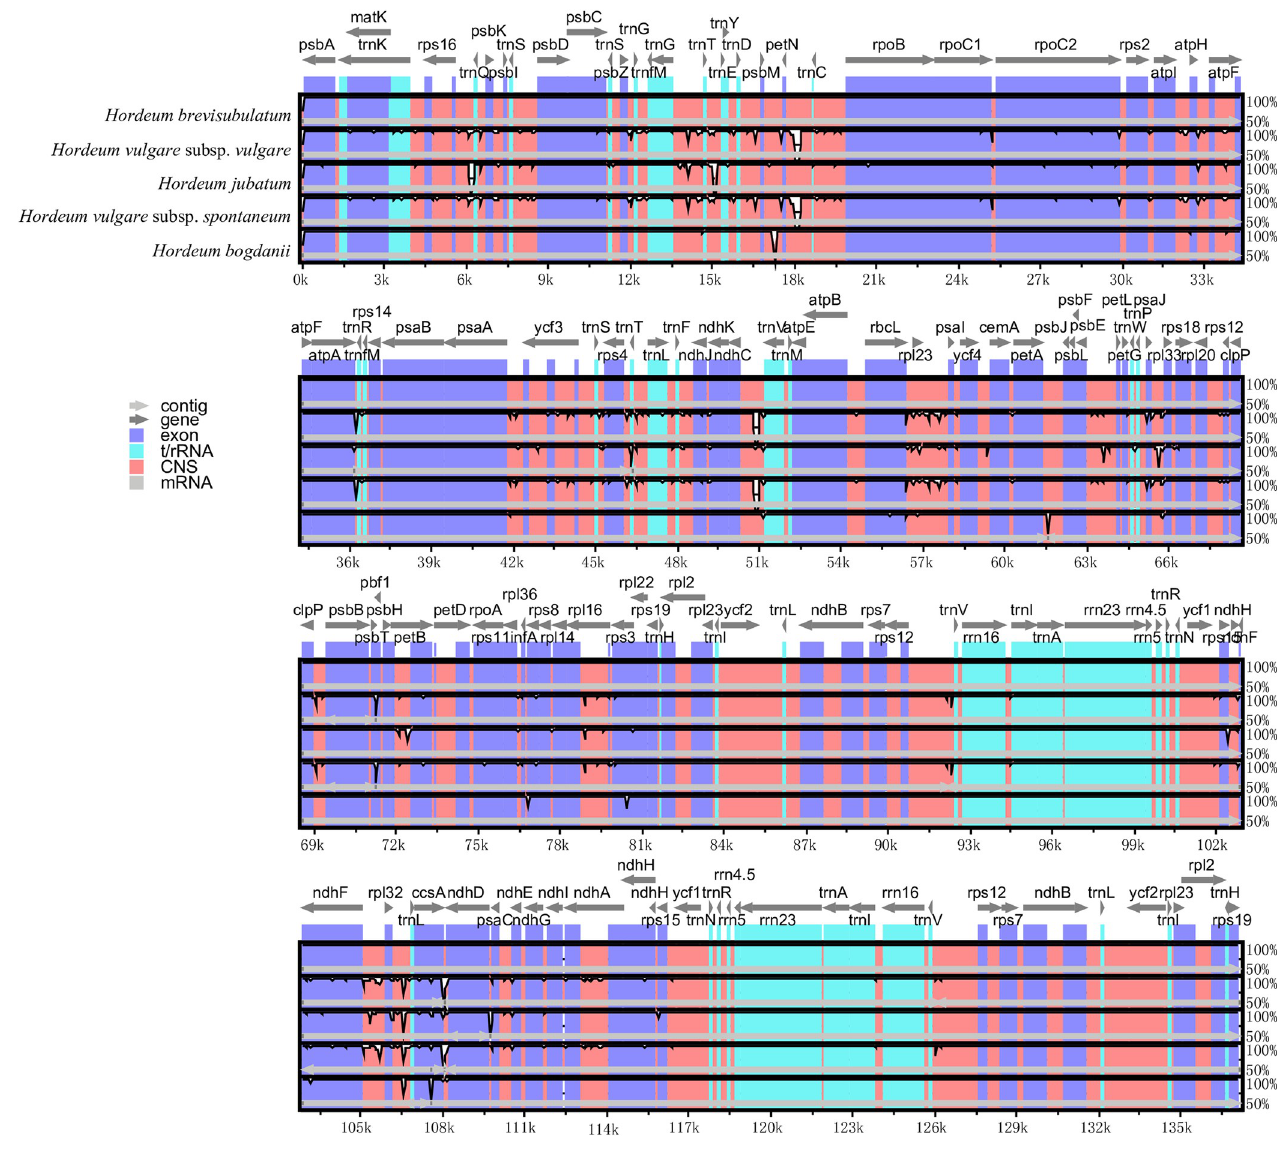
Fig 5. Complete cp genome comparison of five species using the cp genome of H . brevisubulatum as a reference. The grey arrows and thick black lines above the alignment indicate the gene’s orientations. The Y-axis represents identity ranging from 50% to 100%. UTR, untranslated regions. CNS, conserved non-coding